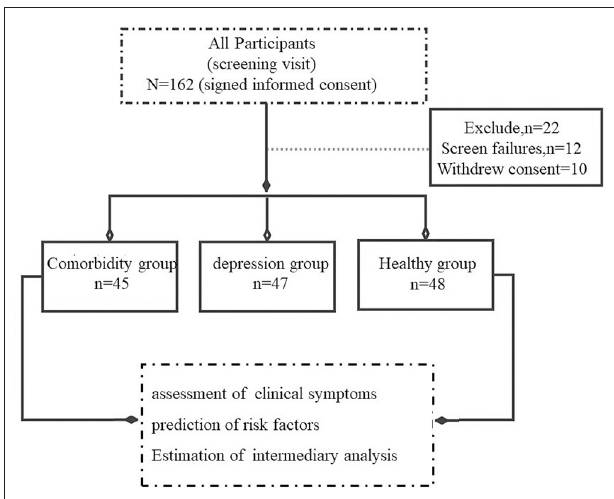
FIGURE 1 | Study selection